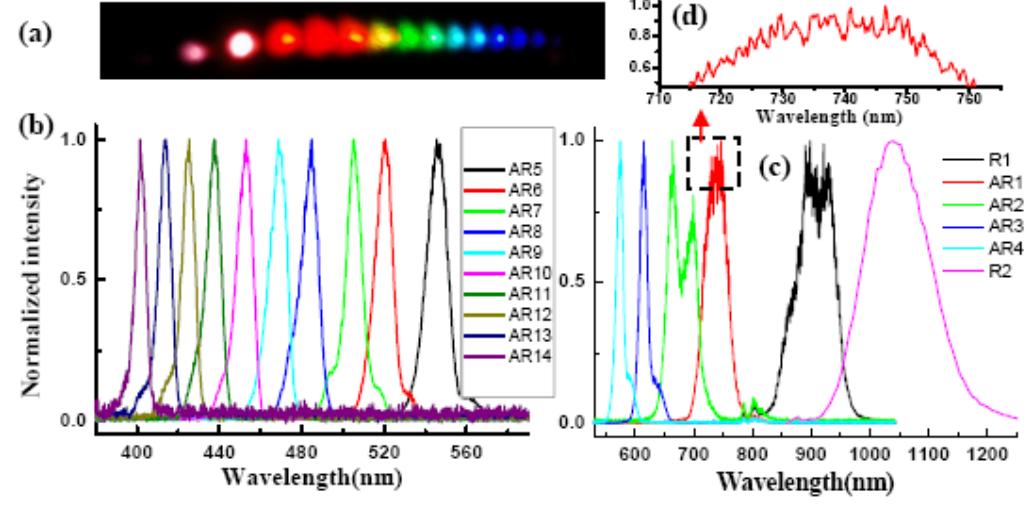
Figure 23. (a) Photograph and (b)spectra of the high-order sidebands and (c) the low-order sidebands (d) enlarged spectrum of peak-range of AR1 observed when a 3mm-thick R850 glass filter was used in beam1 path. AR m ( m = 1 – 14) refers to the m th-order upshifted spectrum, and R n ( n = 1, 2) refers to the n th-order downshifted spectrum